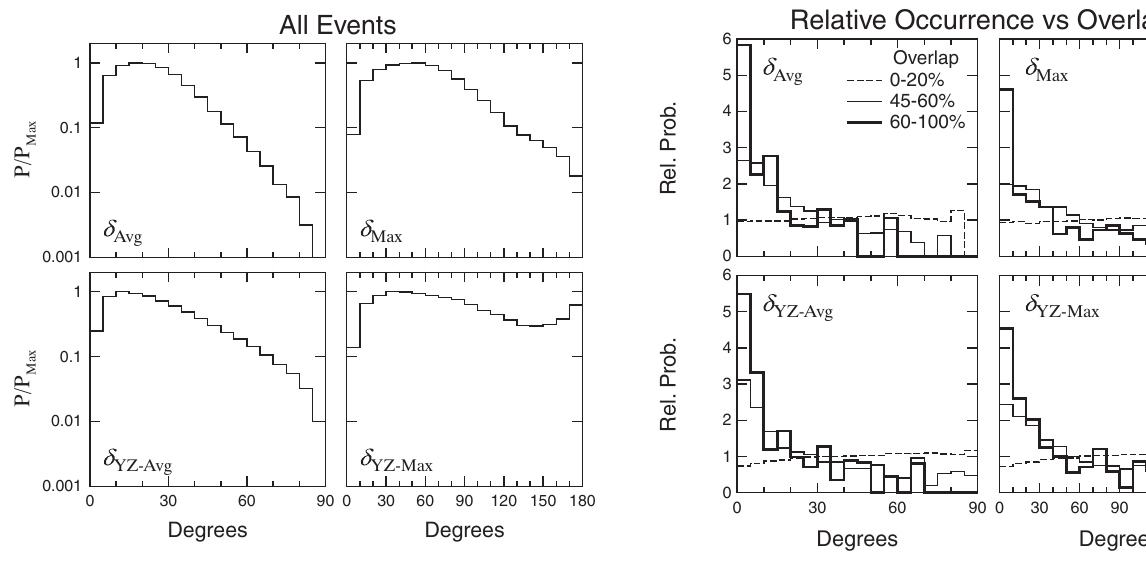
Fig. 3. Relative occurrence probabilities of average and maximum angular departure from average IMF orientation in two-hour intervals for events in three Birkeland current overlap ranges: 0–20% (dashed lines), 45–60% (solid thin lines), and 60–100% (solid thick lines).